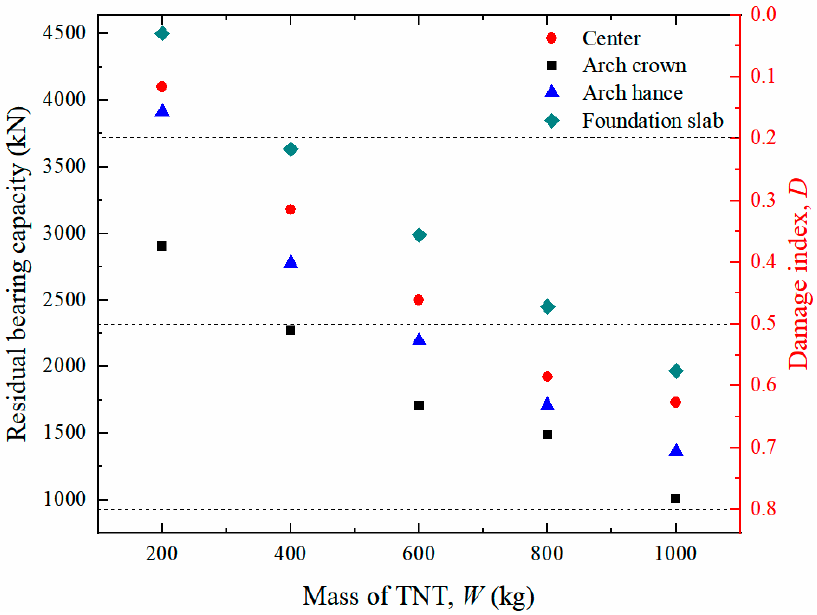
Figure 14. Damage index of the prototype of tunnel entrance with different TNT mass.